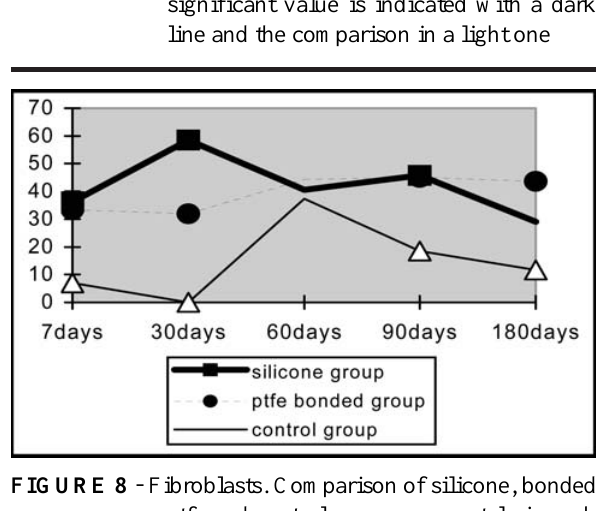
FIGURE 7 - Fibroblasts. Comparison among the subgroups, of each group separately. The significant value is indicated with a dark line and the comparison in a light one